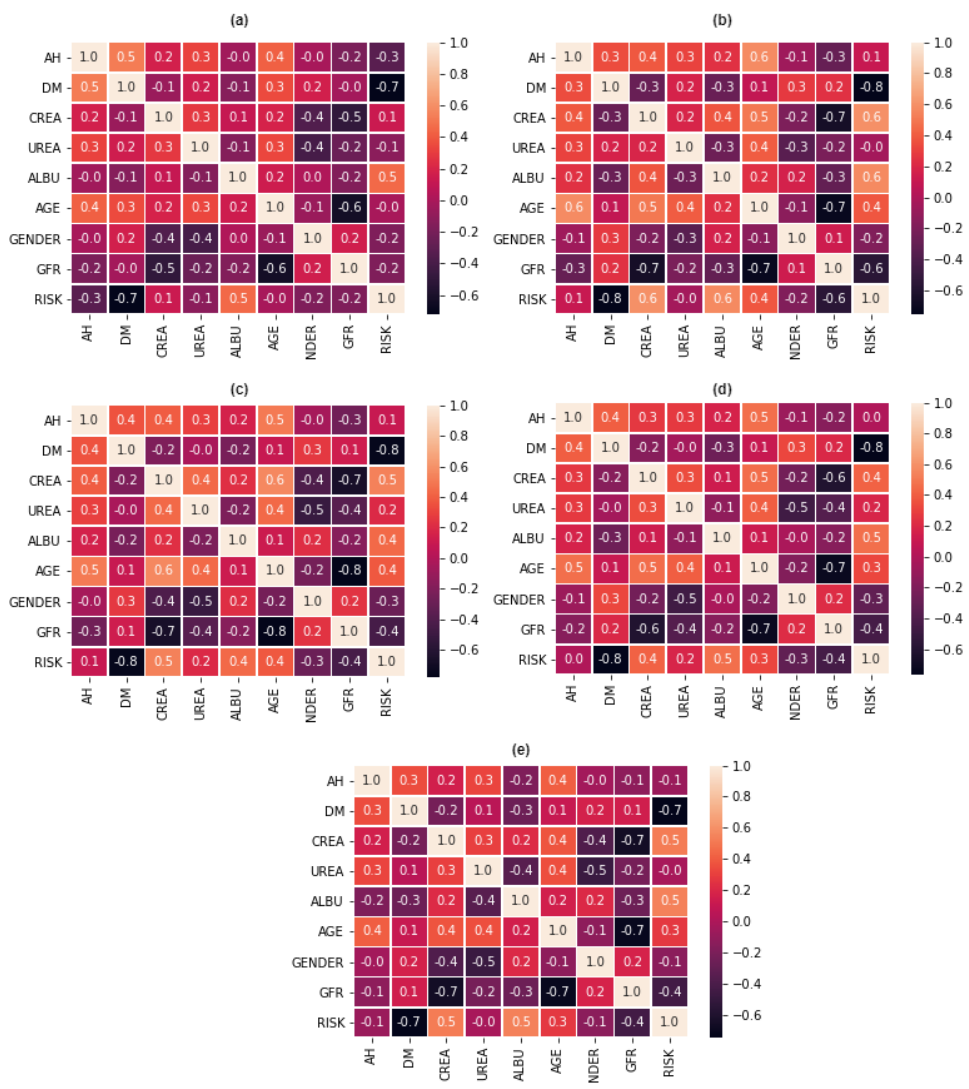
Figure 2. Sample of correlation matrix coefficients. ( a ) Dataset with the 60 real-world records and 54 manually augmented data. ( b ) Dataset with the application of the hold-out method and data further resampled with SMOTE. ( c ) Dataset with the application of the hold-out method and data further resampled with borderline-SMOTE. ( d ) Dataset with the application of the hold-out method and data further resampled with borderline-SMOTE SVM. ( e ) Dataset with CV method with data further resampled with